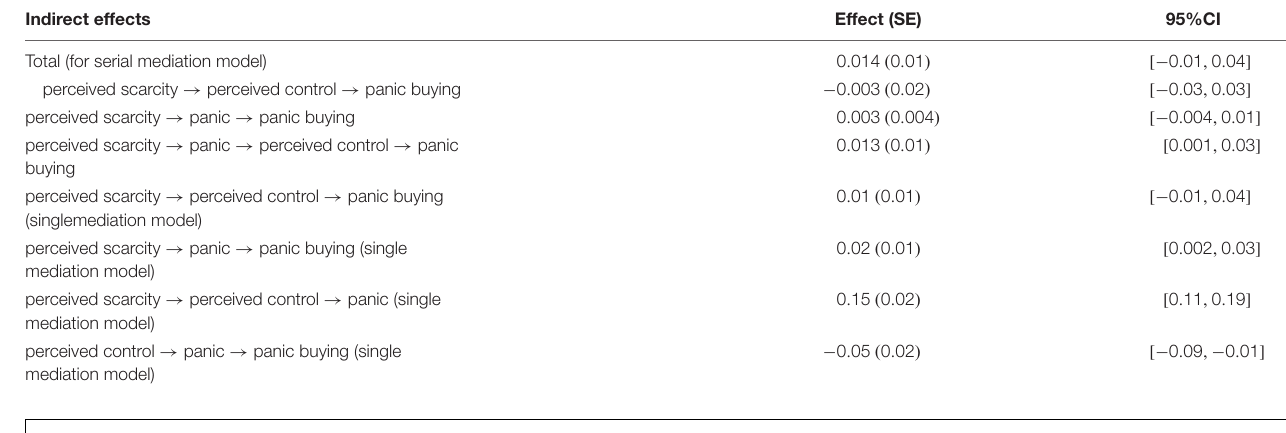
TABLE 3 | Summary of indirect effects in study 2.